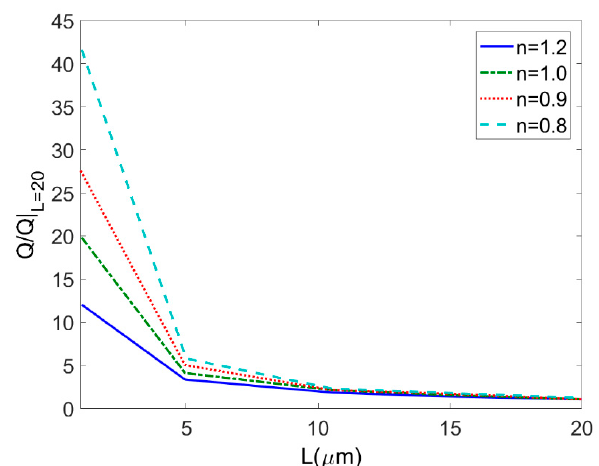
Figure 9. Variation of the total flow rates generalized by the total flow rate when L = 20 μ m with membrane thickness at different flow behavior indices n ( c = 0.01 mol/m 3 , ζ = − 0.1 V, V = 10 V, φ = 0.05).